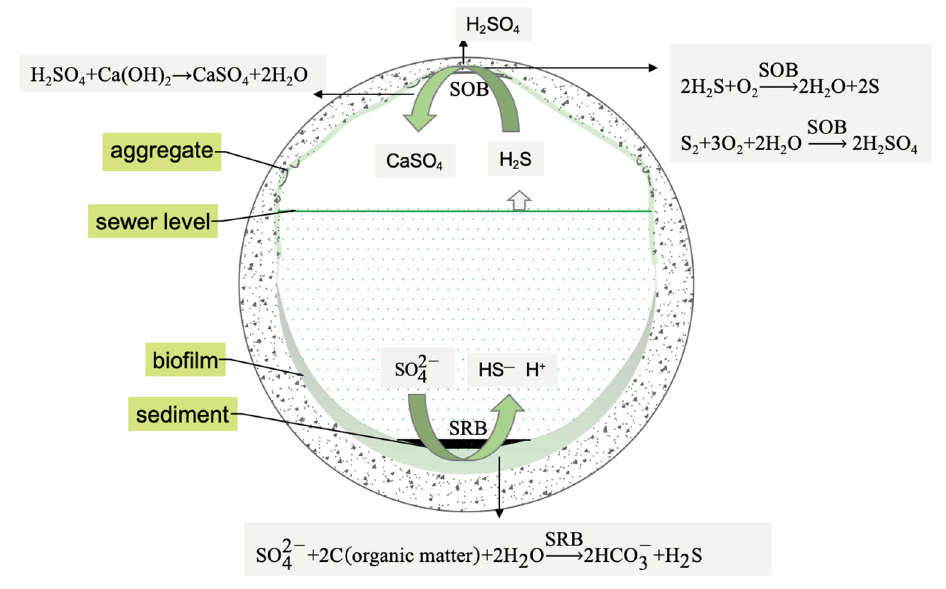
Figure 1. Sulfur cycling procedures in wastewater systems inhabited by microbes.